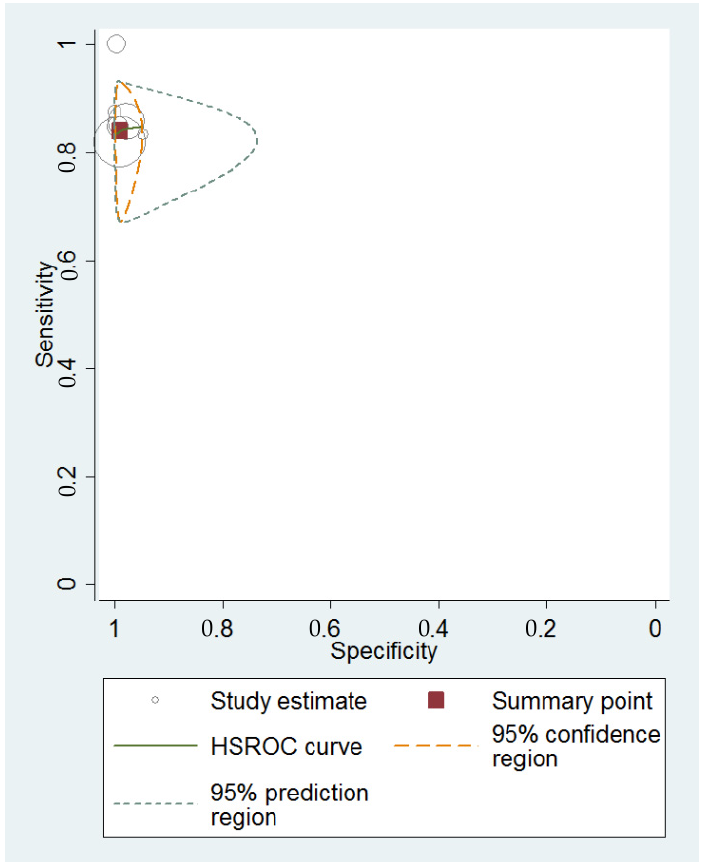
Figure 4. Summary HSROC curve for TVS diagnostic accuracy for hydrosalpinx, showing the sensitivity and specificity for each study and pooled estimation. The orange dashed line around the summary point estimate (red quadrate) represents the 95% confidence region. The green dotted line showing the 95% prediction contour corresponds to the predicted performance considering each of the